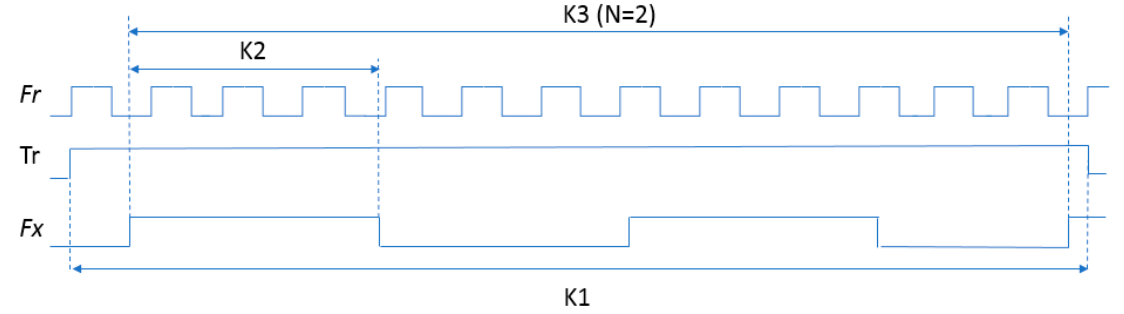
Figure 2. Waveforms illustrating various methods for frequency measurement waveforms.